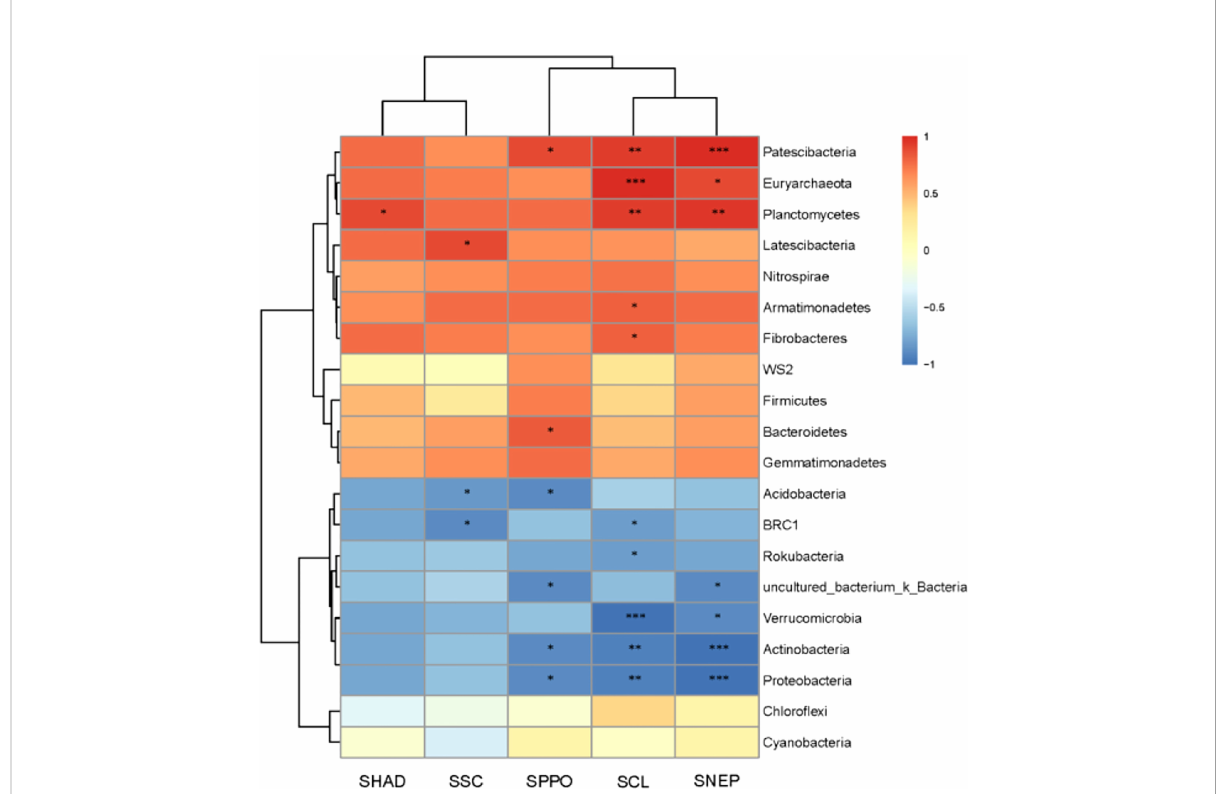
FIGURE 11 Pearson correlation between soil bacteria and soil enzyme vigor in maize root system. SHAD, SSC, SCL, SPPO, and SNEP are the activities of dehydrogenase, sucrase, cellulase, polyphenol oxidase, and neutral protease in soil respectively * represents signi fi cant difference between CE and CK (p<0.05), ** represents extremely signi fi cant difference between CE and CK (p< 0.01), *** represents extremelysigni fi cant difference between CE and CK